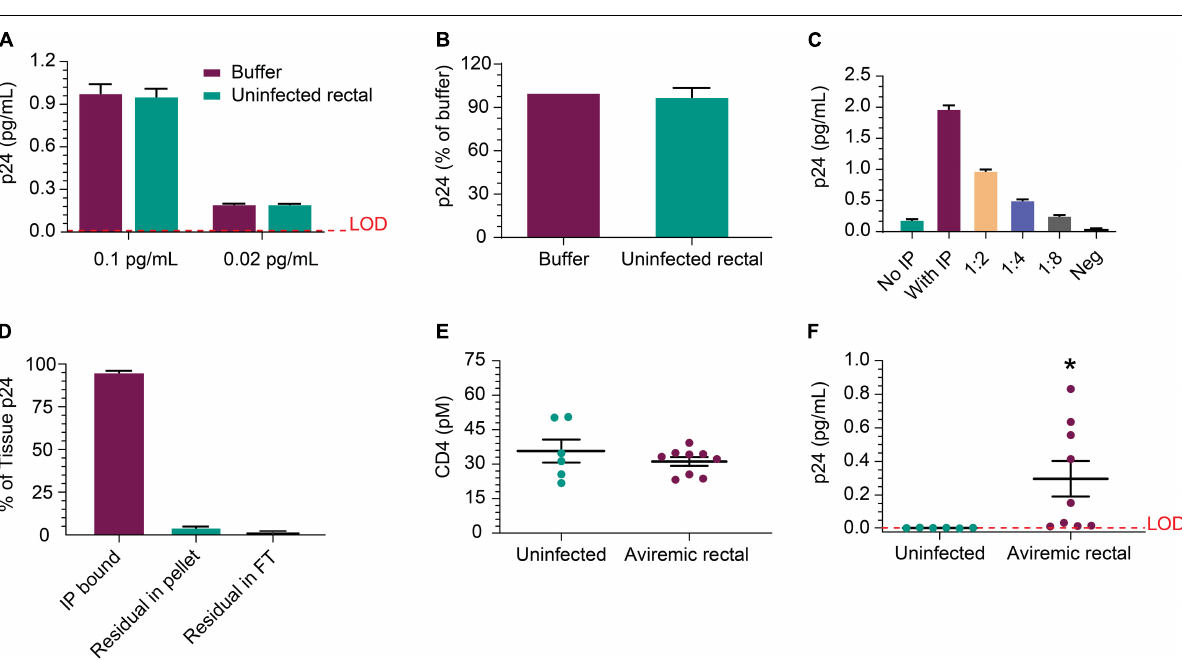
FIGURE 5 | Detection of p24 protein from rectal pinch biopsies. (A) Recovery of recombinant p24 spiked into biopsy lysate at 0.02 and 0.1 pg/mL, respectively, is comparable to recovery from buffer as the matrix after IP concentration. (B) Recovery was comparable between buffer and uninfected rectal lysate matrix when using p24 protein recovered from a viremic donor-derived sample as the protein source for spike-in. (C) Cells isolated from a viremic rectal biopsy were lysed and run in standard p24 Simoa or IP-Simoa. The p24 was enriched by the volume reduction during IP and shows linear signal after dilution supporting signal specificity. (D) Reprocessing of rectal biopsies ( n = 3) for p24 after lysis revealed that a single extraction yielded > 96% of the p24 contained within the biopsy. There was no detectable p24 in solution after IP, indicating complete capture of p24 onto the beads. (E) Comparing measured CD4 protein from HIV-negative and